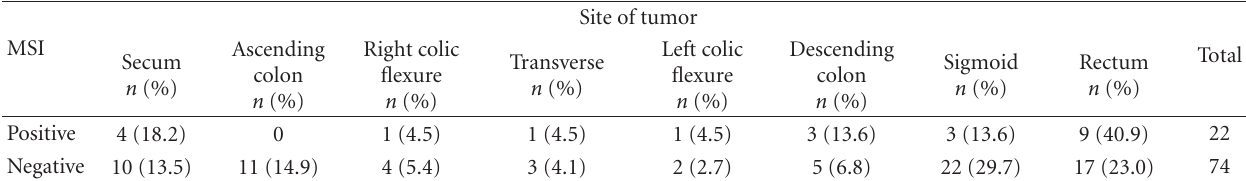
Table 3: The prevalence of MSI in the anatomical regions of large